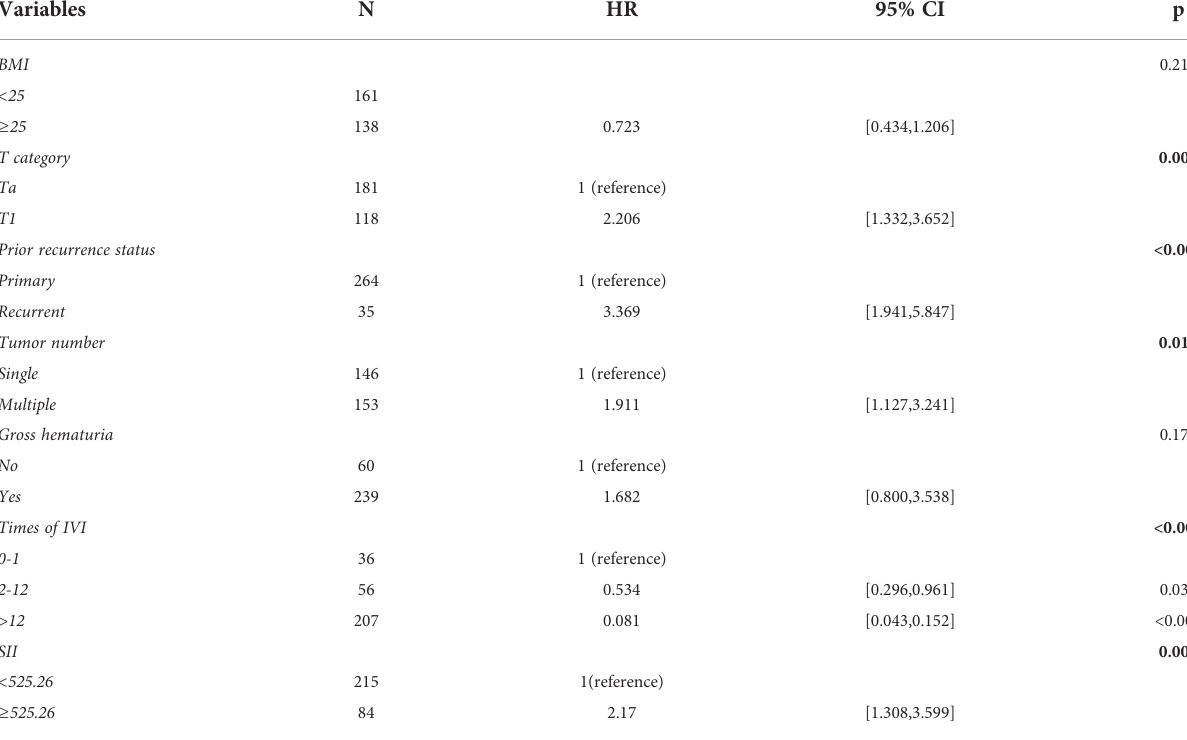
TABLE 3 Univariable Cox regression analysis after the LASSO regression analysis, without tumor invasion locations.